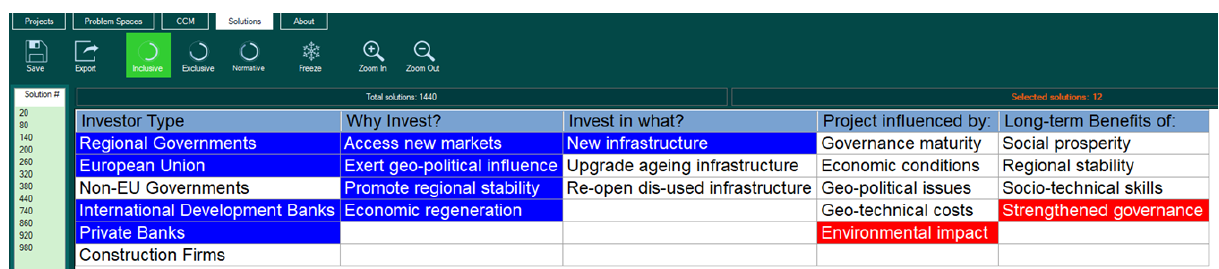
Figure 6: Strengthening governance requirements to mitigate environmental impact appears to be mainly in the development of new infrastructure driven by regional governments via